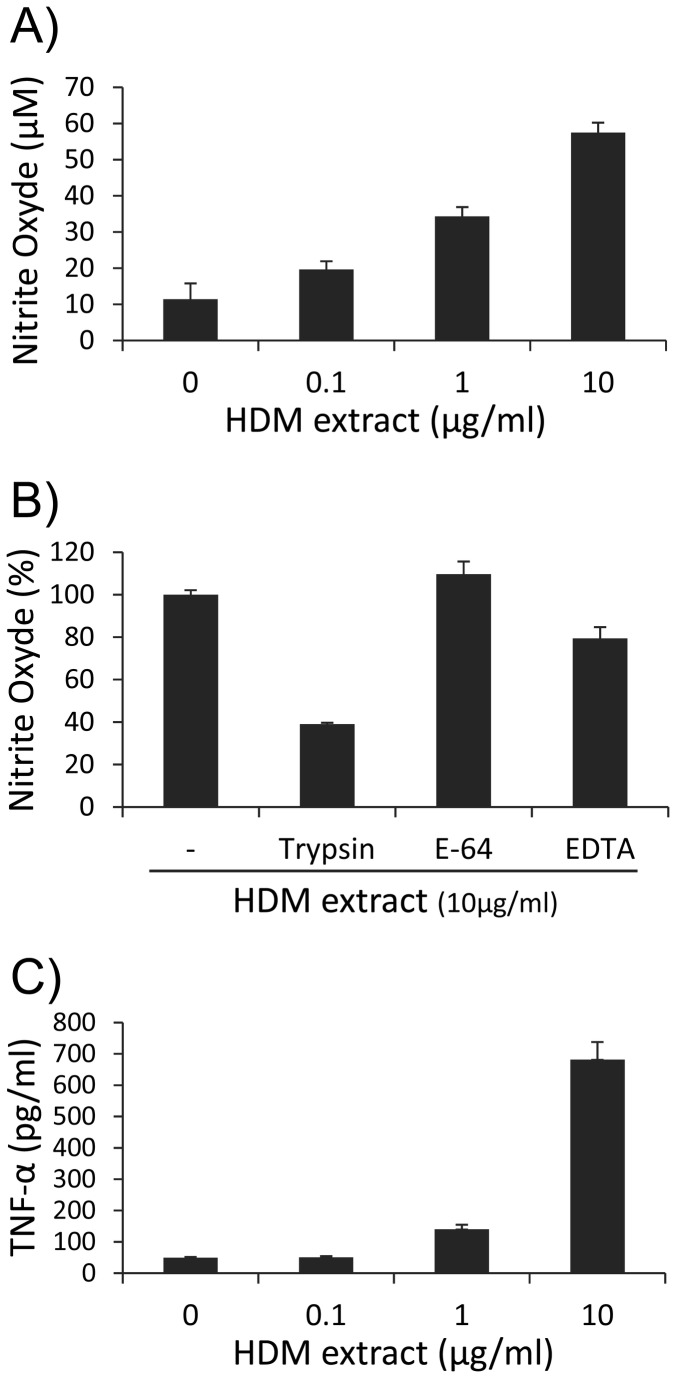
Dose-dependent nitric oxide (NO) production (A) and TNF-α production (C) by HDM extract-stimulated MH-S cells.MH-S cells were plated at 1x106 cells/mL and challenged with increasing concentrations of HDM extract (0.1, 1 and 10 µg/mL) for 48h. Supernatants were collected and analyzed for NO and TNF-α production. (B) Effect of trypsin-treatment and protease inhibitors on the HDM induced NO production by MH-S cells. HDM extract (10µg/mL) was pre-treated with 5% (w/w) trypsin, 20µM E-64 or 100µM EDTA for 4 hours before addition to MH-S cells for 24 hours. Collected supernatants were assayed for NO production. All samples were analyzed in triplicate. Each bar represents the mean ± SEM from three replicate wells.